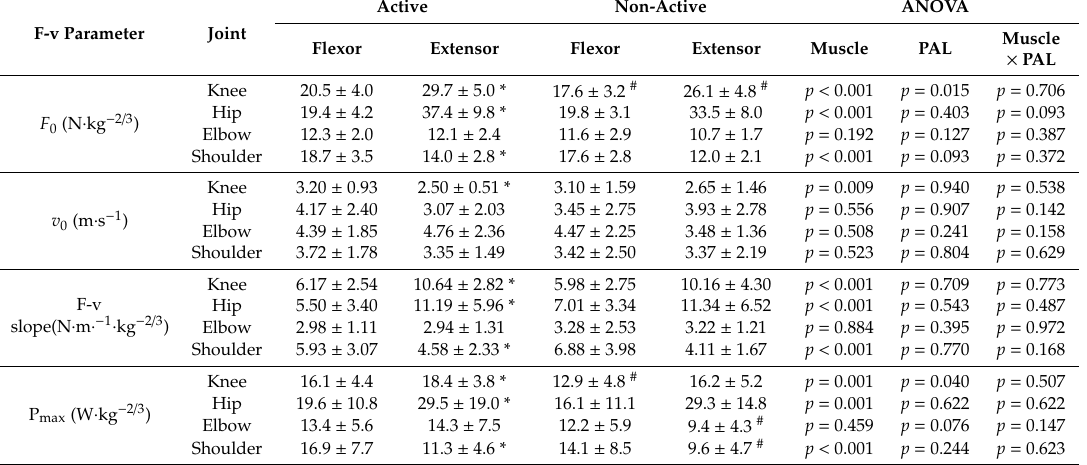
Table 1. Comparison of the force-velocity relationship parameters between muscle groups and physical activity levels for each